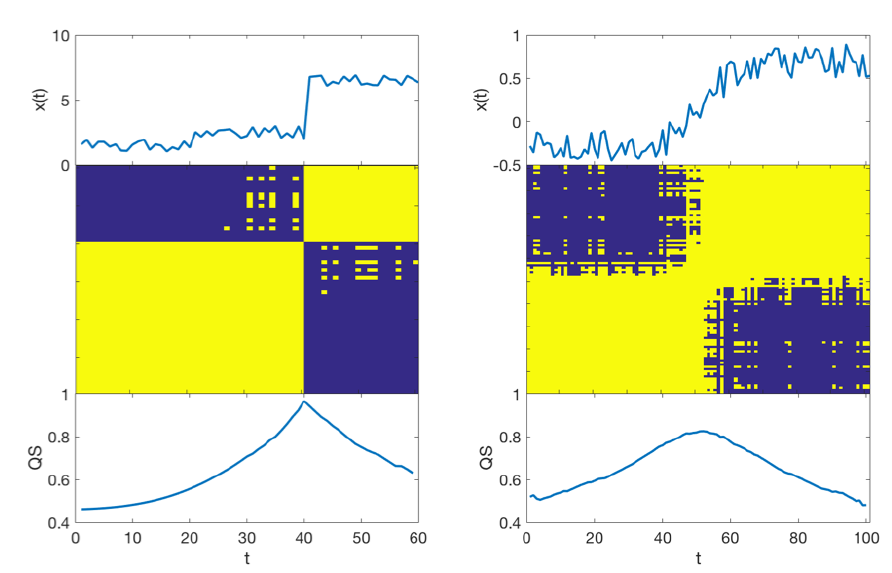
Figure 3. A simulation to demonstrate how the Quadrant Scan visually distinguishes between abrupt and gradual changes. The top panels are the simulated noisy time series, the middle panels are the corresponding recurrence plots (yellow indicates ones and dark blue indicates zeros), and the bottom panels are the resulting Quadrant Scan profiles. The abrupt change is detected as a sharp peak, whereas the gradual change is reflected as a curved peak in the corresponding Quadrant Scan